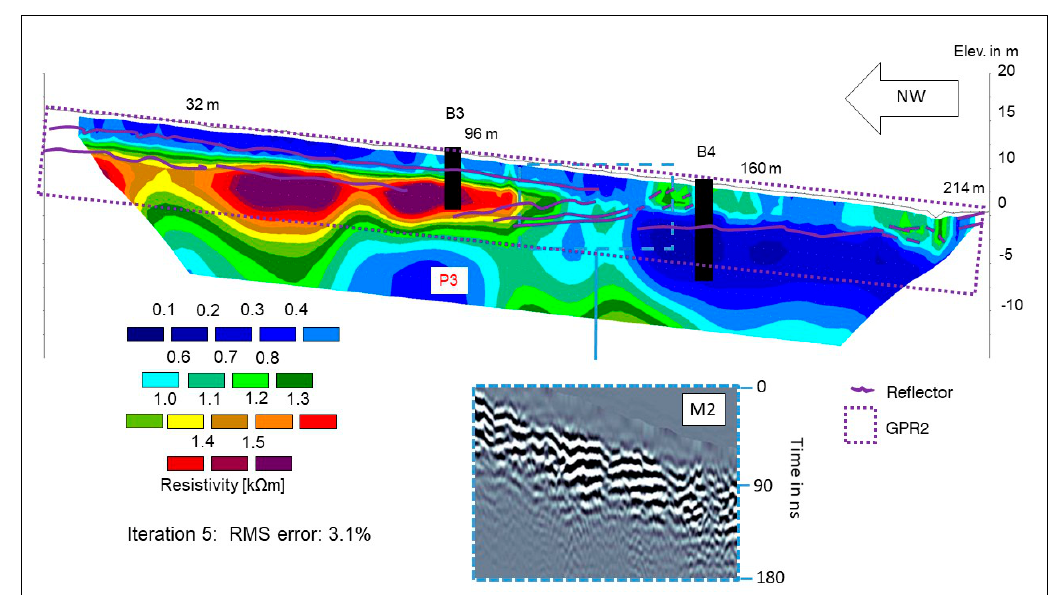
Figure 7. Geophysical surveys in the drained part of "Thranenbruch". Geosciences 2018 , 8 , x FOR PEER REVIEW 11 of 21 Boreholes